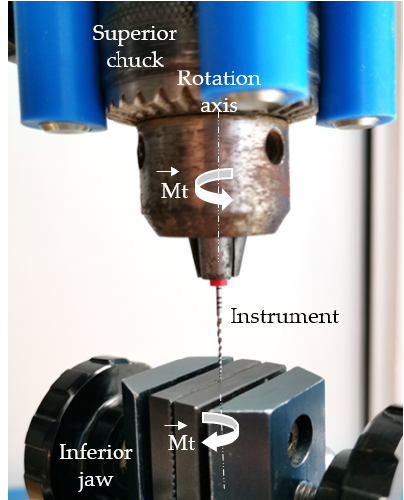
Figure 3. The configuration of the torsion test.